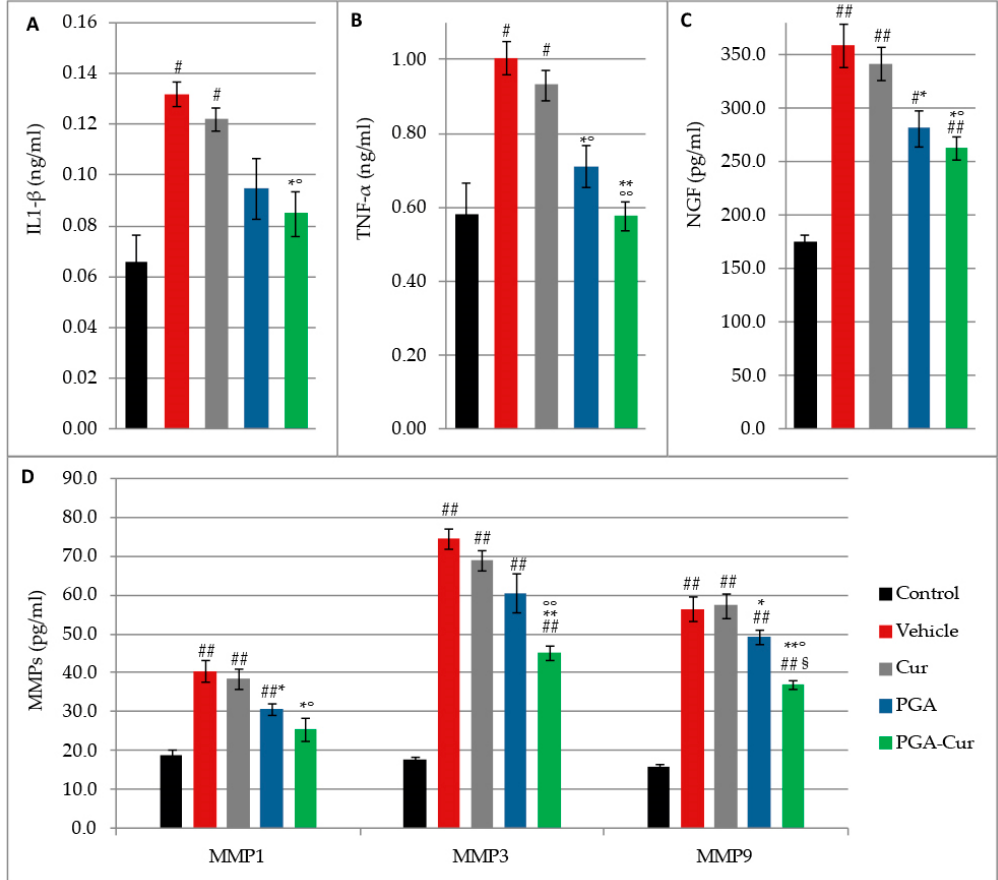
Figure 6. Effect of PGA and curcumin (Cur) given individually or in a co-micronized formulation (PGA-Cur) on monoiodoacetate-induced increase in the serum level of cytokines (IL1- β , TNF- α ), nerve growth factor (NGF), and metalloproteases (MMP1, 3, 9). Data are expressed as mean ± standard error of the mean (N = 10/group). # p < 0.05 and ## p < 0.0001 vs. control; * p < 0.05 and ** p < 0.0001 vs. vehicle; ° p < 0.05 and °° p < 0.0001 vs. Cur; § p < 0.0001 vs. PGA.